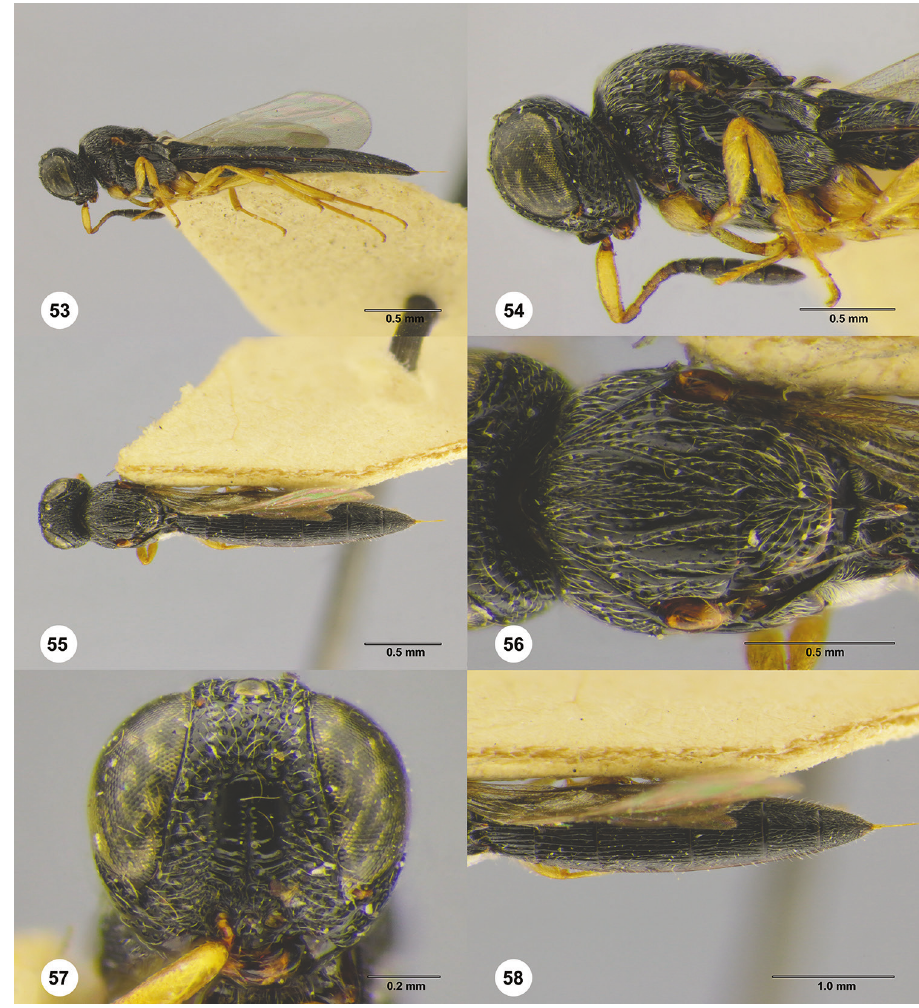
Figures 53–58. Triteleia persimilis , female, holotype (ZMAS 0139). 53 Lateral habitus 54 Head and mesosoma, lateral view 55 Dorsal habitus 56 Mesosoma, dorsal view 57 Head, anterior view 58 Meta- soma, dorsal view. smooth. Sculpture of ventral metapleural area: rugose. Setation of ventral metapleural area: dense. Color of legs: orange-yellow. Sculpture of hind coxa: densely punctate. Color of metasoma: black. T1 horn in female: present. Sculpture of posterior mar- gin of T1 in female: largely longitudinally striate with horn punctate rugose. Transverse sulcus on T2: present. Sculpture of T2–T5: densely longitudinally striate, with fine punctures in interstices. Sculpture of T6 in female: densely punctate. Length of T6 in female: distinctly longer than wide. Apex of T6 in female: round. Sculpture of